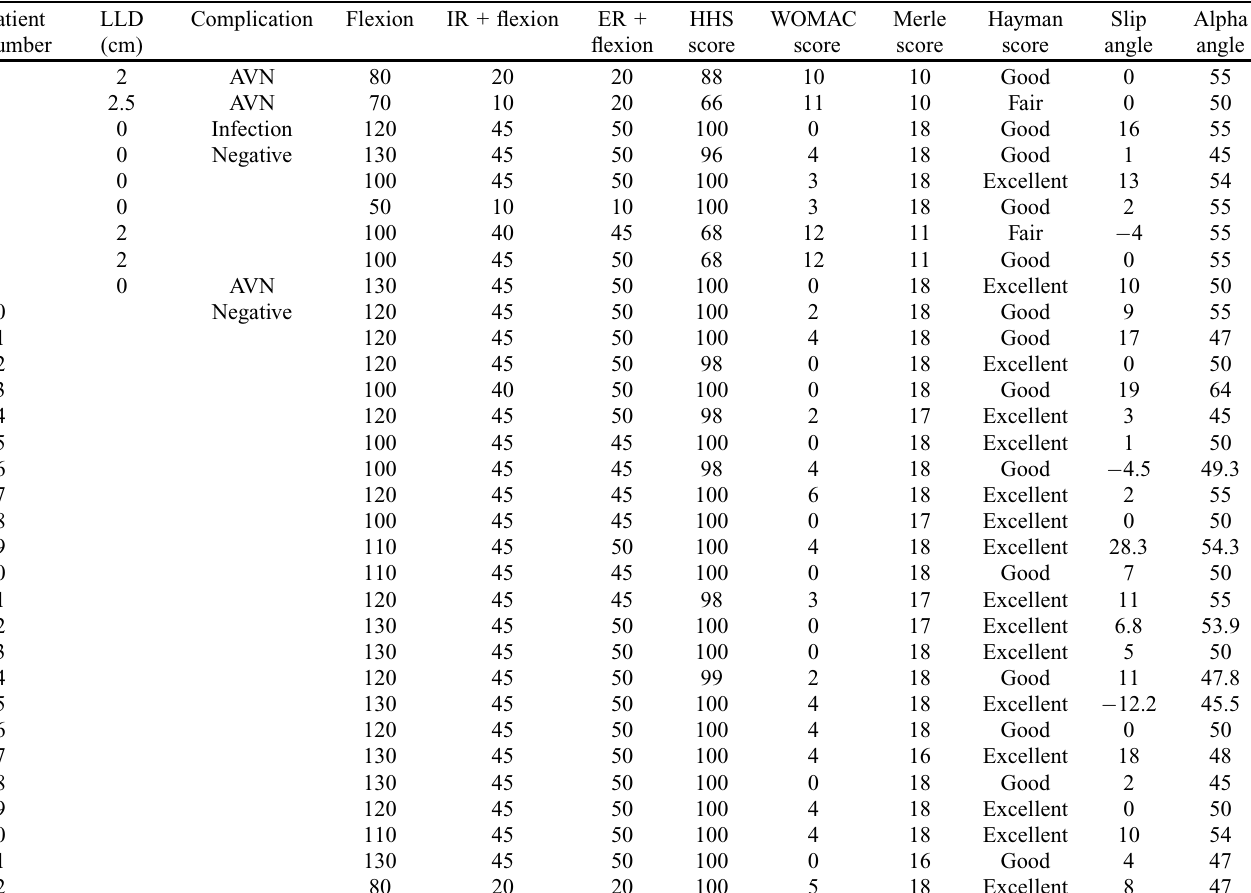
Table 3. Postoperative features of SCFE patients treated with modified Dunn